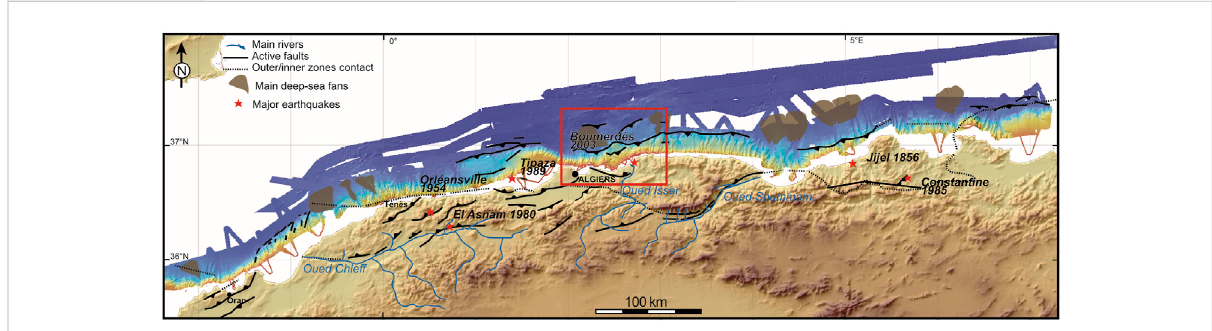
FIGURE 1 Overallland-seaphysiographyandstructuralsketchoftheAlgerianmargin,withthesixmajorearthquakes(redstars)feltsince1850.Mainrivers and deep-sea fans are shown. Black lines show the approximate position of the main active faults close to the surface. Dashed line is the assumed position of the suture zone corresponding to the closure of the Tethyan (Maghrebian) oceanic lithosphere. Red square is the study area where the Mw 6.9 May 2003 Boumerdès earthquake occurred. Modi fi ed after Bouillin (1986), Domzig et al. (2006), Yelles-Chaouche et al. (2006) and Cattaneo et al.